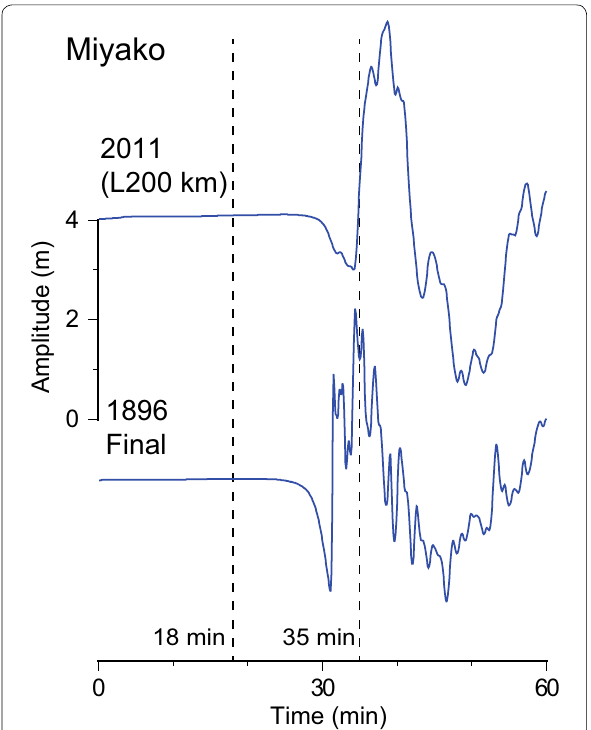
Fig. 4 Tsunami waveforms computed at Miyako from the 2011 model (8 subfaults) and the 1896 final model. Dashed lines (18 min and 35 min after the earthquake origin time) indicate the observed tsunami arrivals of first and maximum waves (see